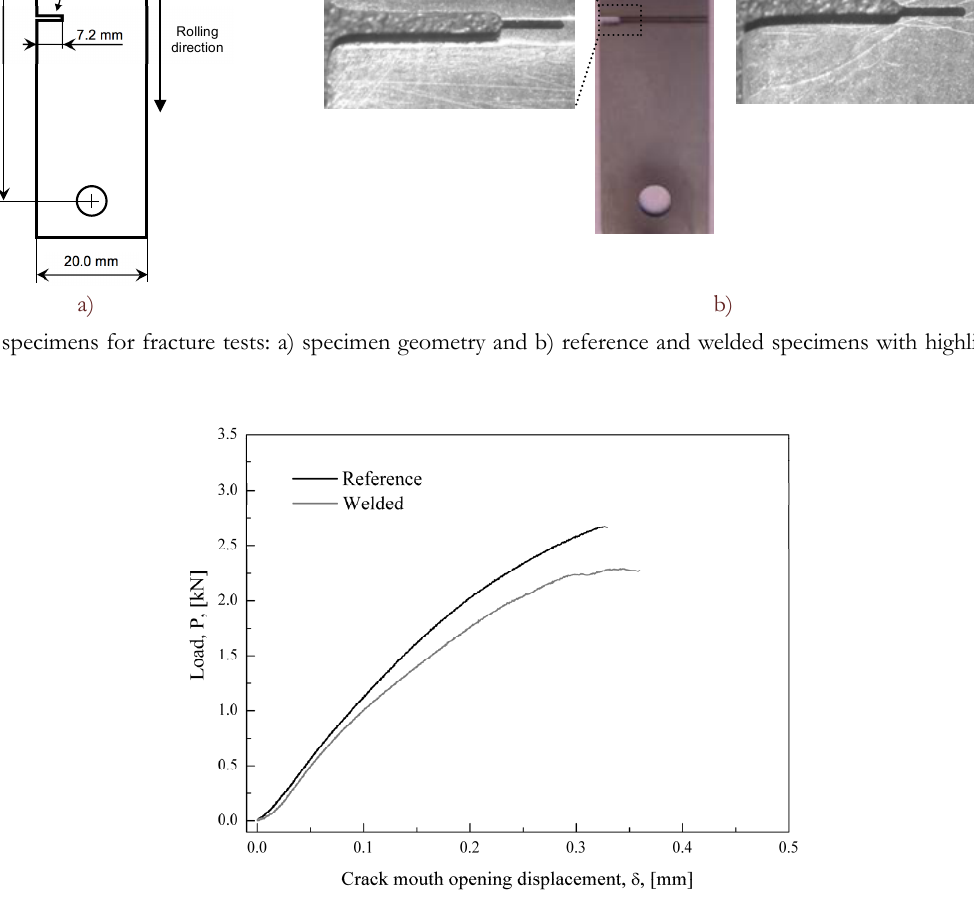
Figure 9: Comparison between the load vs Crack mouth opening displacement curves of the reference and welded specimens [7].